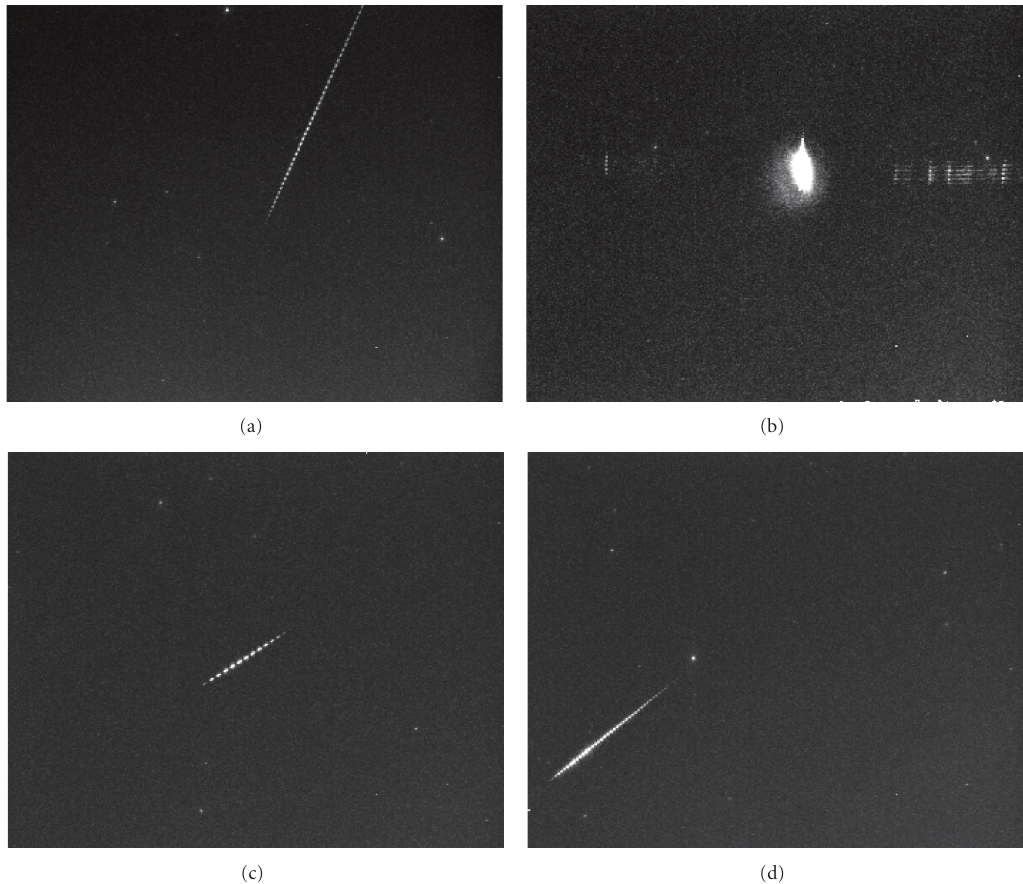
Figure 2: Low resolution mages of four of the meteors recorded by the robotic video CCD station. (a) Mag. 0 Virginid meteor registered on April 11, 2009 at 3 hours 37 minutes 34 ± 0.01 s UTC. (b) Mag. − 8 Lyrid fireball registered on April 23, 2009 at 3 hours 24 minutes 07.49 ± 0.01s UTC. The emission spectrum can also be noticed on this image. (c) Mag. − 1 sporadic meteor registered on April 27, 2009 at 4 hours 05 minutes 54.12 ± 0.01s UTC. (d) Mag. − 2.5 Alpha-Bootid meteor registered on April 28, 2009 at 0 hour 36 minutes 51.52 ± 0.01s